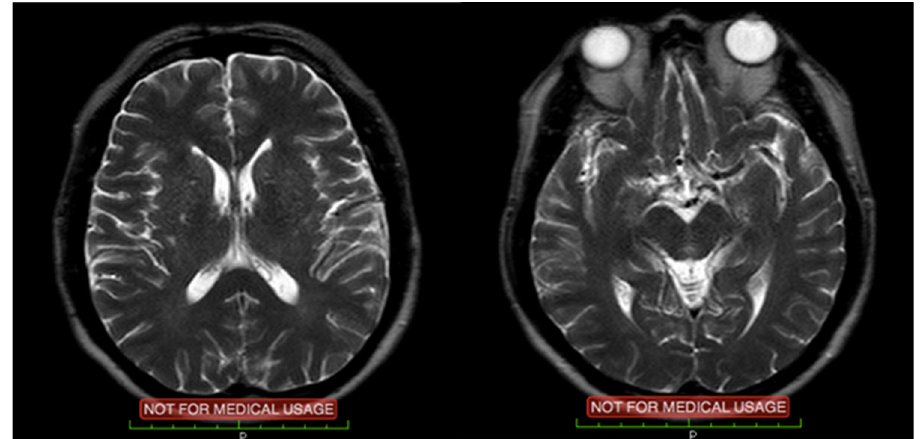
Figure 2. Brain magnetic resonance imaging (MRI) showing no signs of acute infarction or hemorrhagic